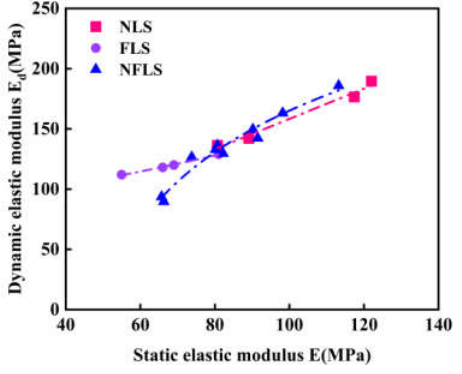
Figure 12. Relationship between static and dynamic elastic modulus. Table 4. Calculation results of λ and ζ According to the UCS test data, the elastic modulus of NFLS is substituted into the objective function [25,26], and the parameters λ and ζ are identified by particle swarm optimization algorithm. The identification results are shown in Table 4. The mean value